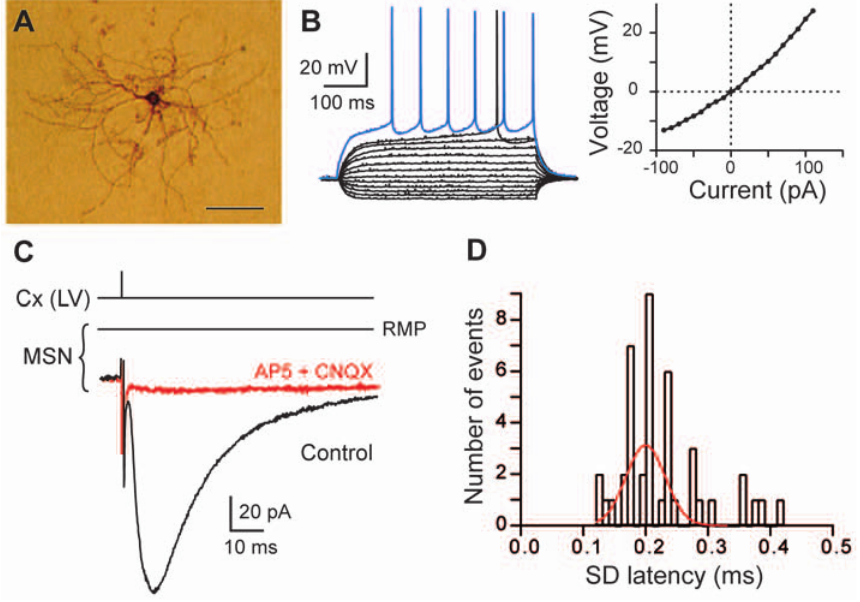
Figure 1. MSN characterization and corticostriatal monosynaptic transmission. ( A ) High magnification of a MSN injected with biocytin (scale bar, 100 m m). ( B ) MSN membrane properties and spiking pattern: a hyperpolarized RMP, an inward rectification (illustrated in the steady-state I- V relationship) and a long depolarizing ramp to the action potential threshold leading to a delayed spike discharge. Raw traces show voltage responses to 500 ms current pulses from 2 90 pA to 110 pA with 20 pA steps and to + 40 pA (blue trace) above action potential threshold. ( C ) Cortically-evoked MSN EPSCs (averages of 7 traces) in control and with CNQX (10 m M) and AP5 (50 m M). ( D ) Distribution of latency SD was centered on 0.20 ms and fitted by a Gaussian function. These values of SD latency indicate a monosynaptic corticostriatal transmission because inferior to 0.5 ms. Cx (LV), cortical layer V.